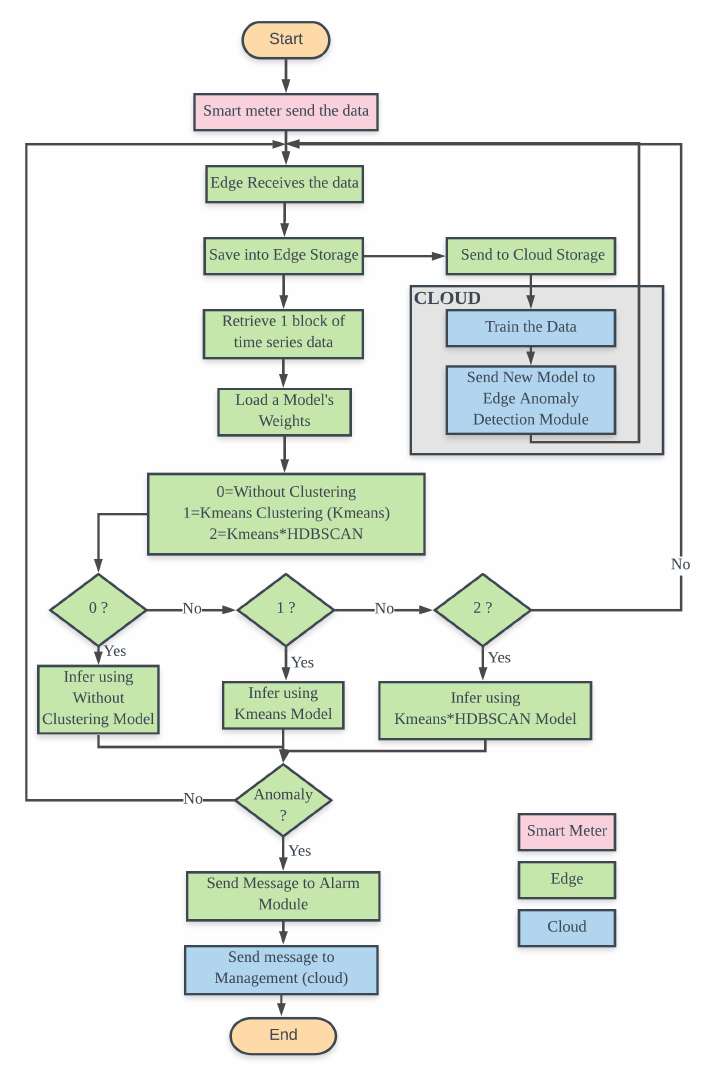
Figure 4. Anomaly Detection System